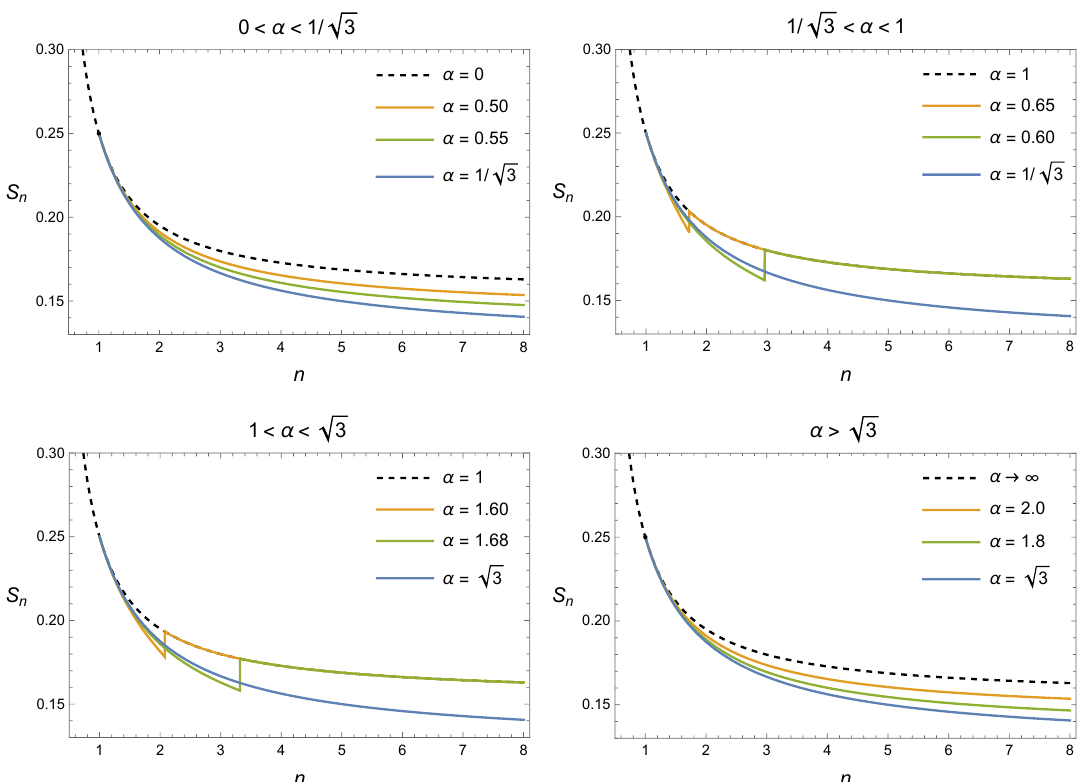
Figure 2 . The Rényi entropies as a function of n for different values of α (AdS 4 ). The dashed line is for the SAdS case, and the blue line is for α = 1 / 4 at n = 1 (for all α 6 = 1 ), where the second derivative has discontinuity. When 1 / zeroth-order phase transition of black holes leads to discontinuity of the Rényi entropies at n